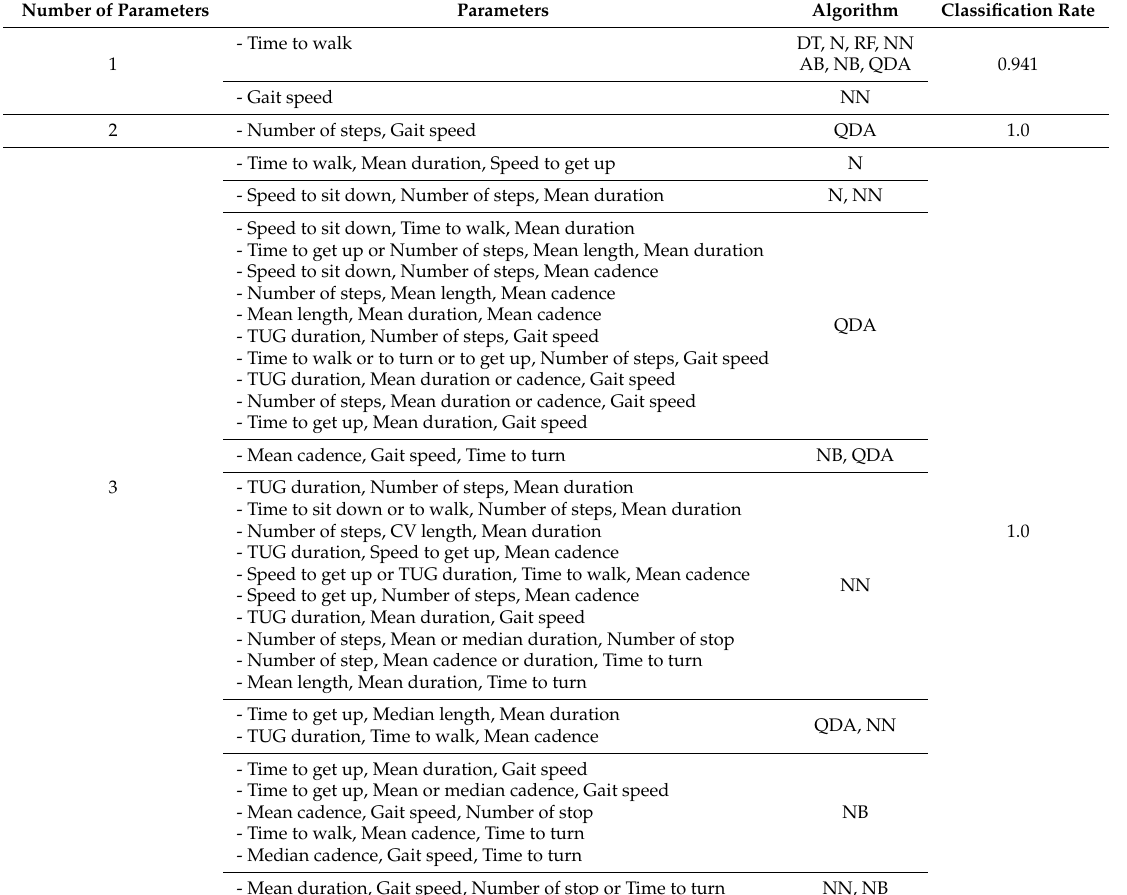
Table 6. Best parameter combinations for the two classes problem. The best classification score is presented in the fourth column. A score of 1 would be a perfect score, i.e., without any classification error. The third column indicates the algorithm giving the best result (NN = Neural Net, NB = Naive Bayes, DT = Decision Tree, Random Forest = RF, AB = AdaBoost, N = Nearest Neighbors, QDA = Quadratic Discriminant